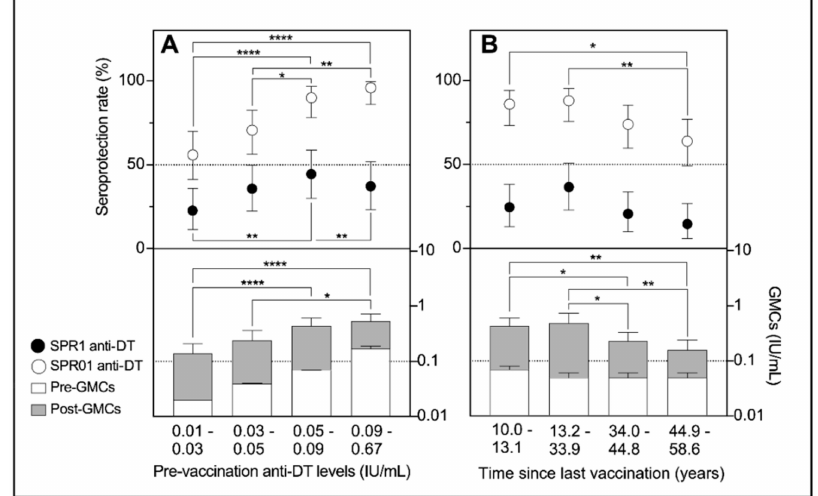
Figure 1. Seroprotection rates of 0.1 IU / mL and 1.0 IU / mL thresholds including the GMCs of pre- and post-booster immunisation against diphtheria in dependence on the quartile-stratified pre-booster levels ( A ) and time since the last vaccination ( B